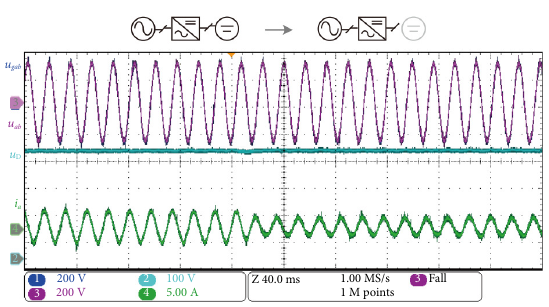
Fig. 8 Switching process from the balanced mode to the ac dominant mode with the VSSM loop.